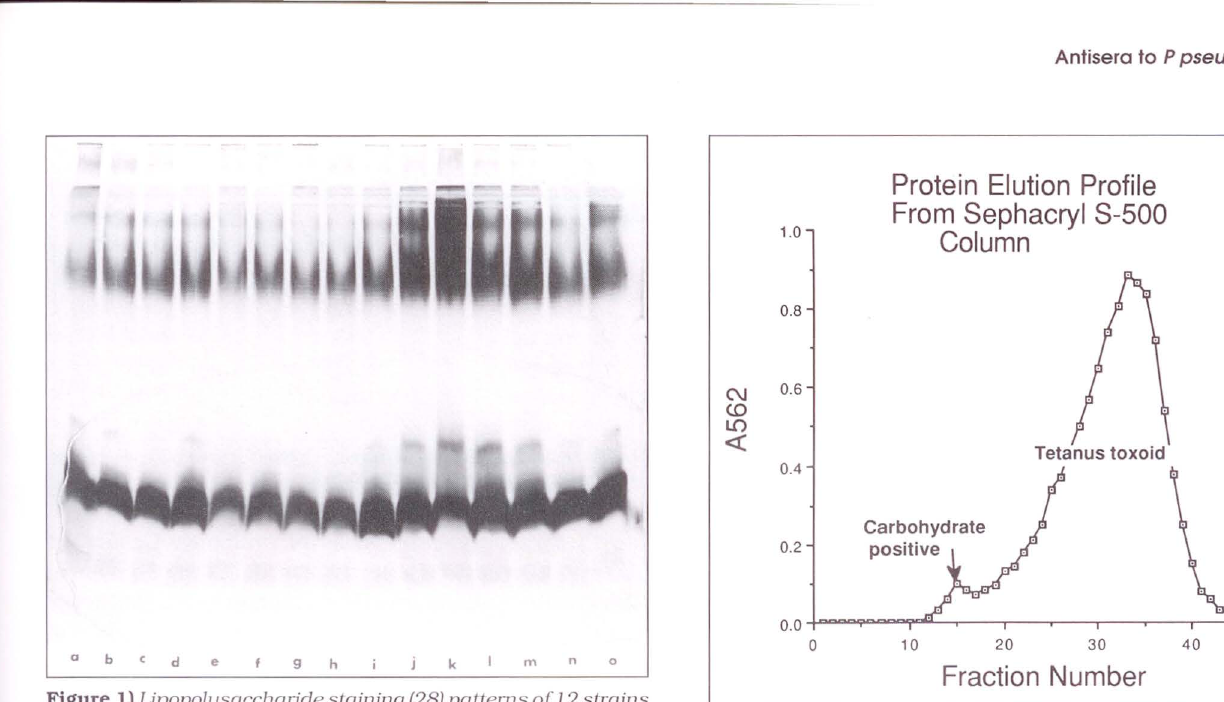
Figure 1) Lipopolysaccharide staining (28) patterns of 12 strains of proteinase K-digested whole cells of Pseudomonas pseudo mallei. Strains in the lanes are: a.b: 365a: c: 365c: d: 392a: ej: 392]: g.h: 316a: i: 316c:j: 305a: k: 305d: l: 415a: m: 415c: